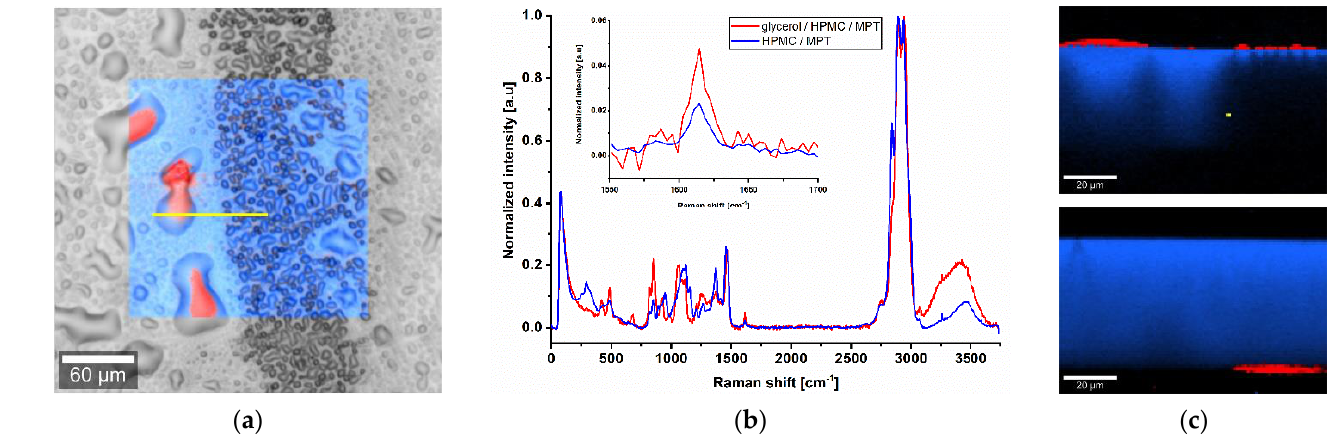
Figure 5. Raman microscope images of ODF imprinted by I7. ( a ) Surface scan with an area of 200 × 200 µm, spatial resolution of 1 µm and 0.05 s exposure time. ( b ) Average normalised Raman spectra of the surface scan with magnified characteristic MPT peak at 1615 cm −1 . ( c ) Depth scan of the cross-section from top and bottom side of the ODF with an area of 100 × 70 µm along the yellow line in ( a ), spatial resolution of 1 µm and 0.2 s exposure time. Red: mixture of glycerol, HPMC and MPT; blue: mixture of HPMC and MPT.